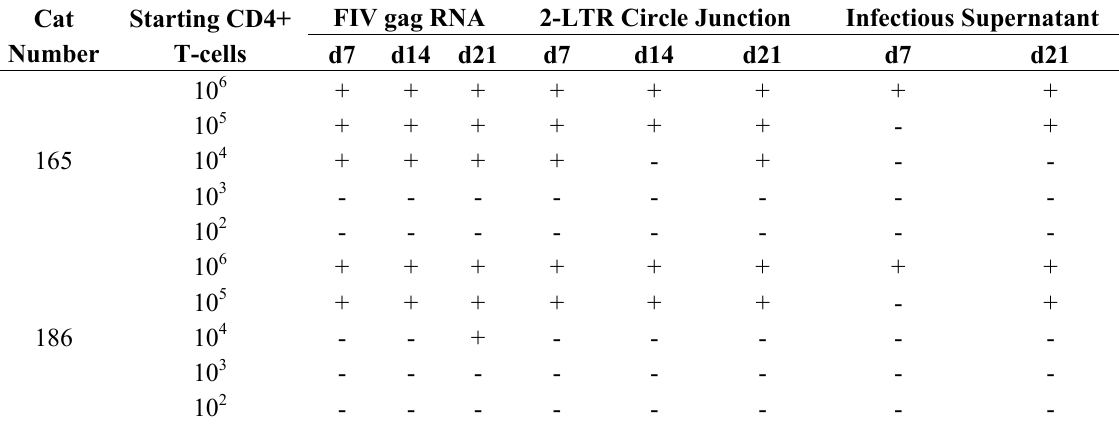
Table 1. Limiting dilution CD4+ T-cells from 2 feline immunodeficiency virus (FIV)- infected cats cocultured with specific pathogen-free (SPF) feline peripheral blood mononuclear cells